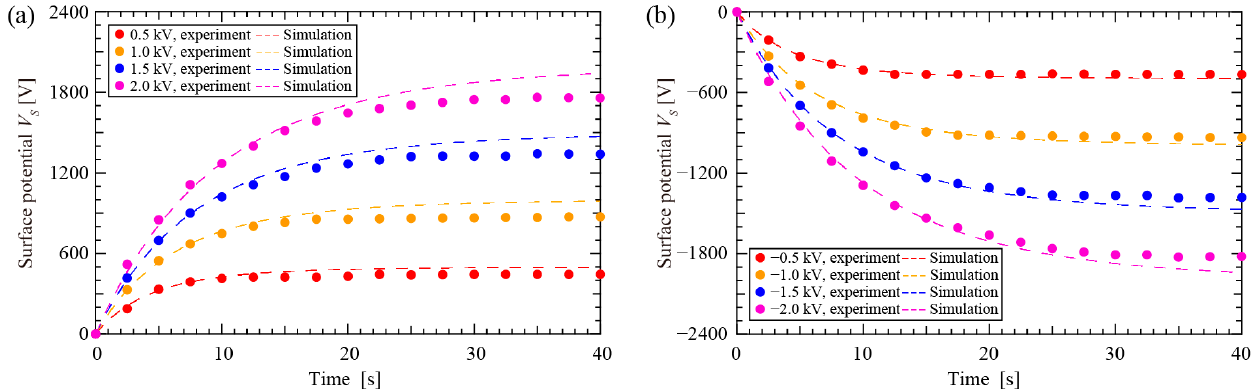
Figure 5. Surface potential of soft X-ray charging PTFE electret. ( a ) Positive charge deposition; ( b ) Negative charge deposition.